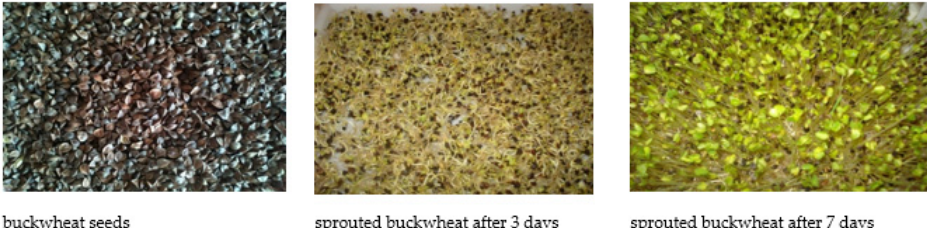
Figure 2. Buckwheat achenes and sprouted buckwheat at 1–7